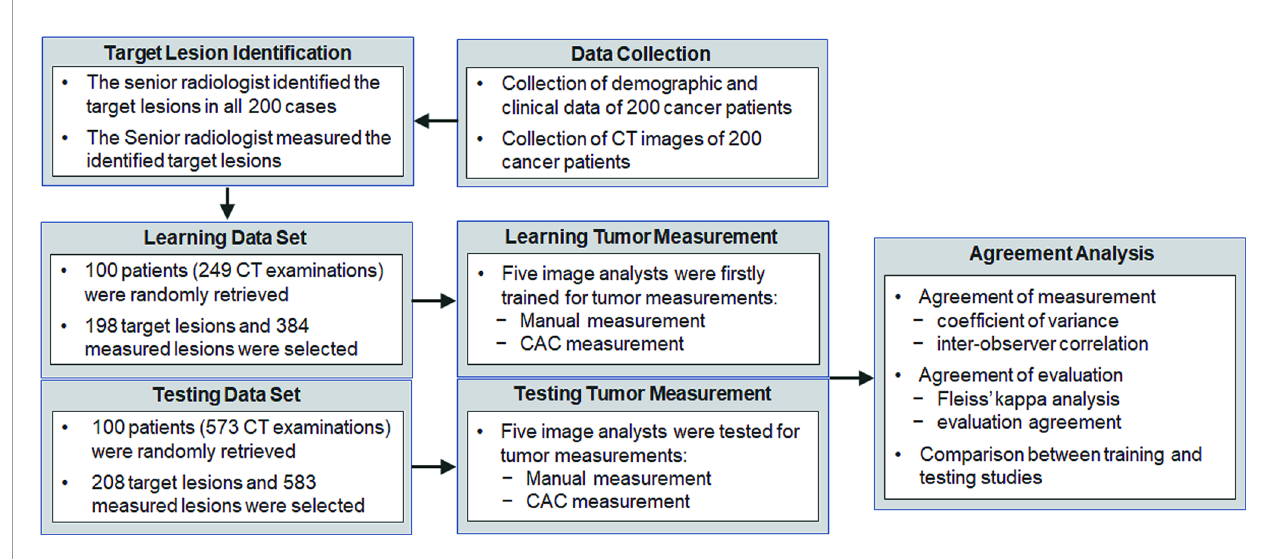
FIGURE 1 | The fl ow chart of the study. Data collection and the design of the